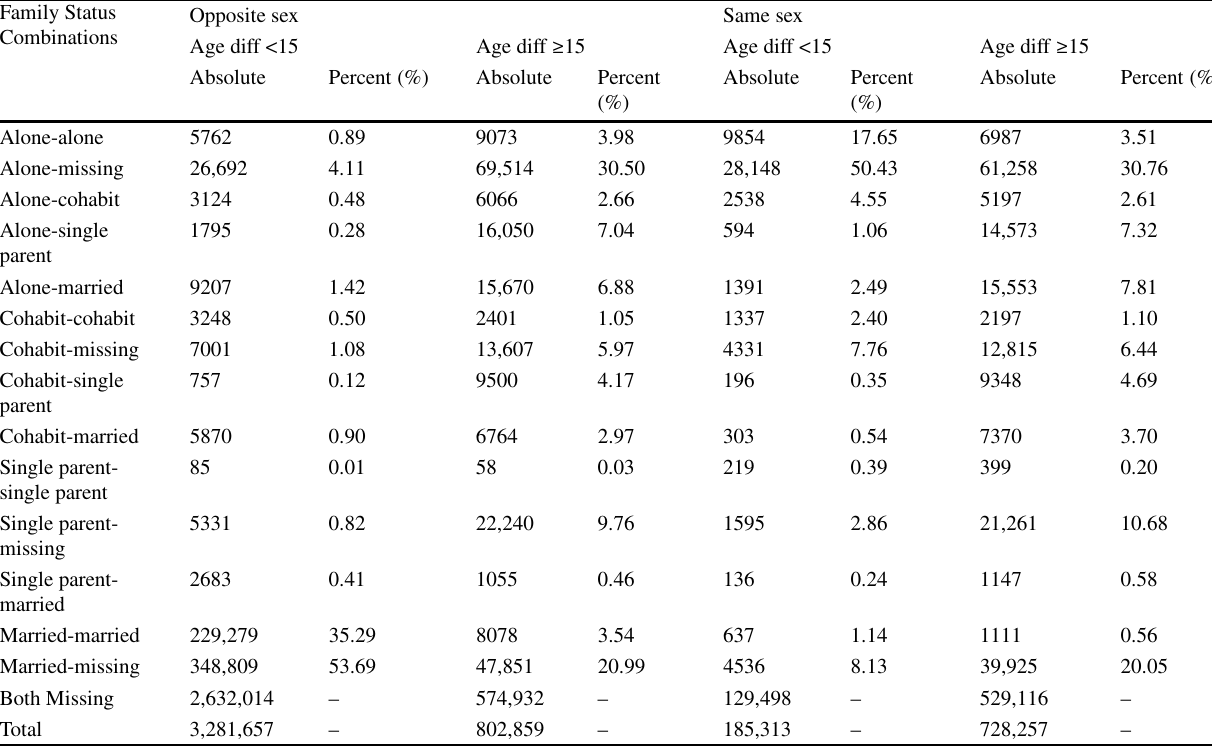
Table 5 Family Status Composition, for matched couples Family Status